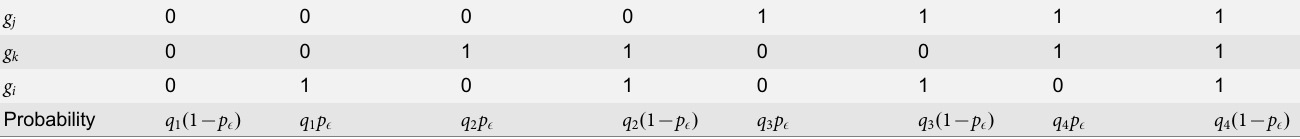
Table 1. The theoretical distribution of ( g i , g j , g k ) for the relation g i ~ ( g j _ g k ) + E